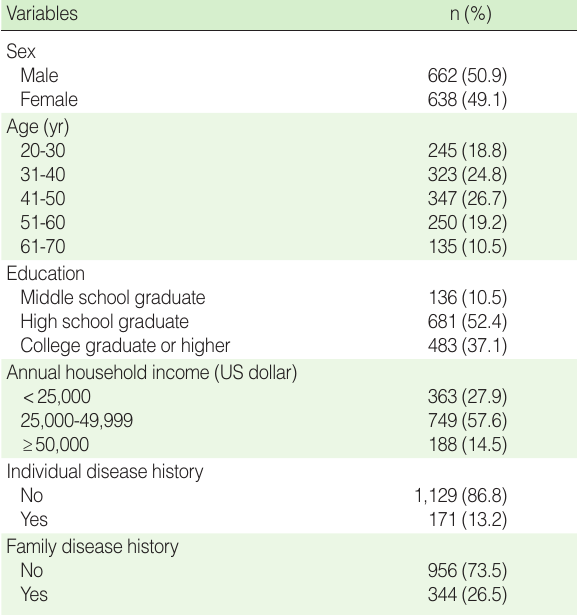
Table 1. Demographic